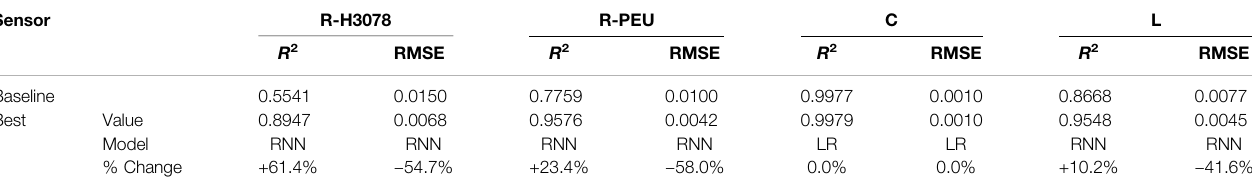
TABLE 1 | Improvement in average R 2 and RMSE across the last three folds by the best performing model for each sensor type.